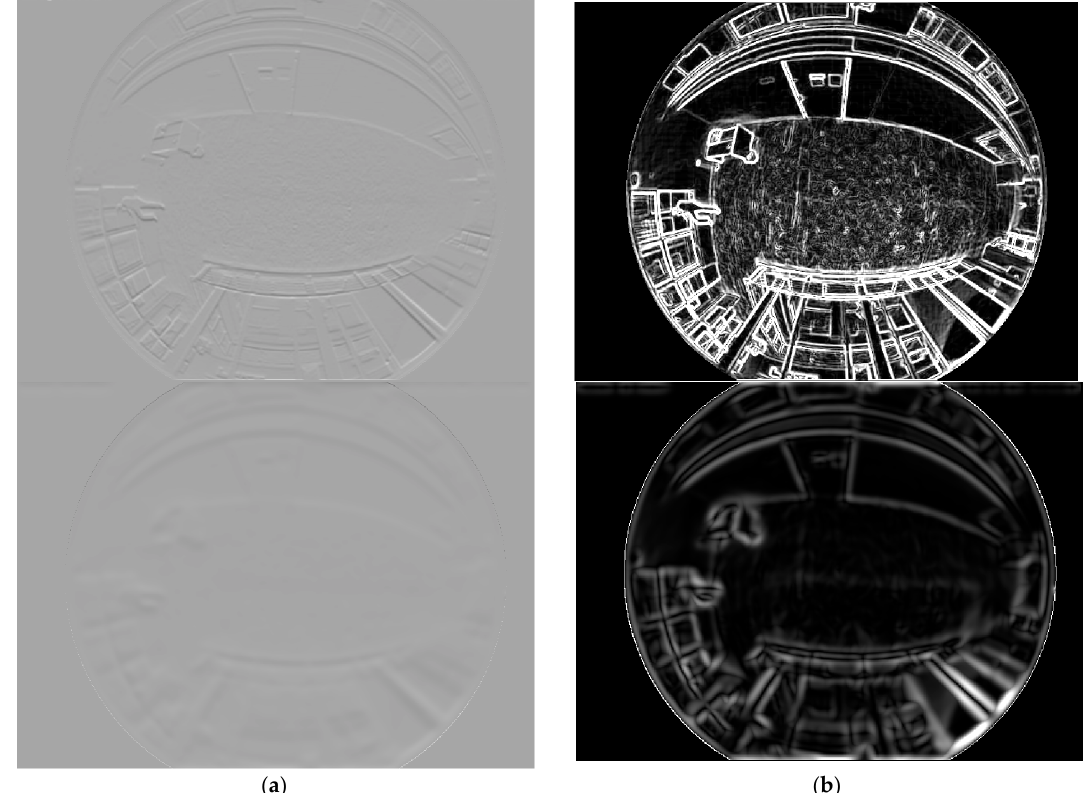
Figure 12. ( a ) The resulting I x using the proposed algorithm for different scales ( k = 1 and k = 20 in Equation (19)); ( b ) the magnitude of the image gradient at the same scales.